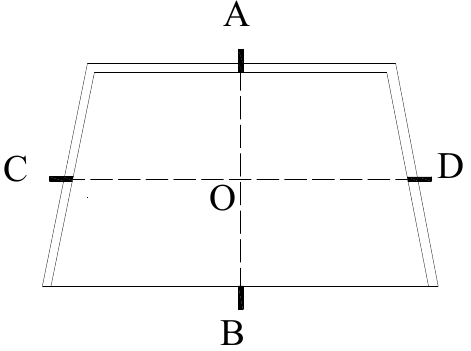
Figure 20. Layout of monitoring points.